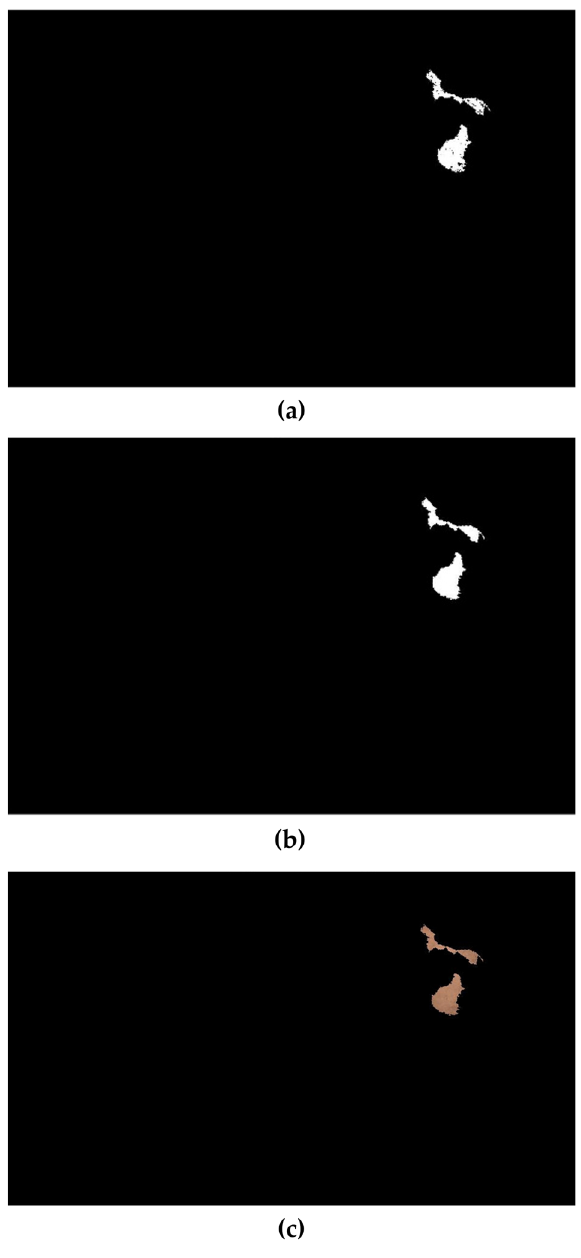
Figure 5. The obtained results of image 1. ( a ) Border smoothed, ( b ) region filled, ( c ) The big particle region of missing color area